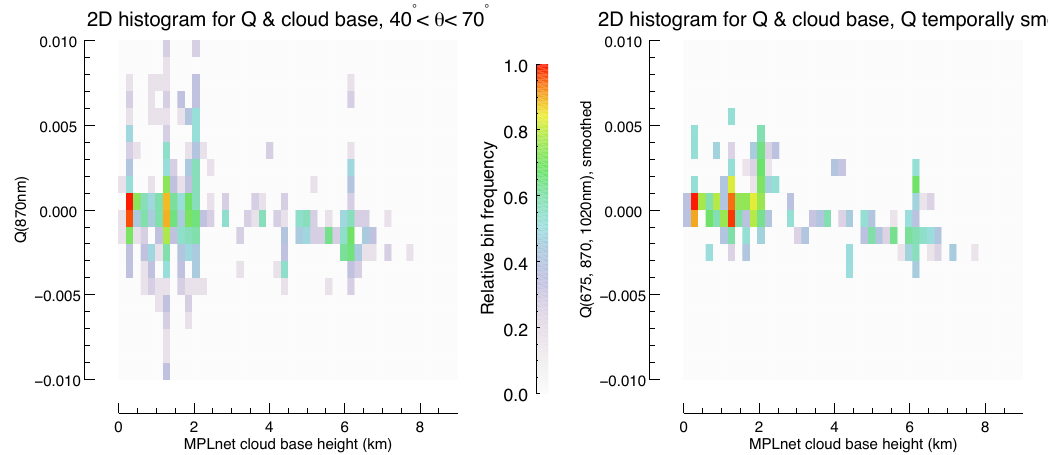
Figure 14. Two-dimensional histograms of Q (870nm) with respect to MPLNET cloud base height (left) and the smoothed multispectral (675, 870, and 102nm) Q product versus the same (right) with the multi-wavelength Cimel instrument at NASA GSFC, for December 2012. The apparent inverse relationship between Q and cloud base height is consistent with the simulations in Sect.